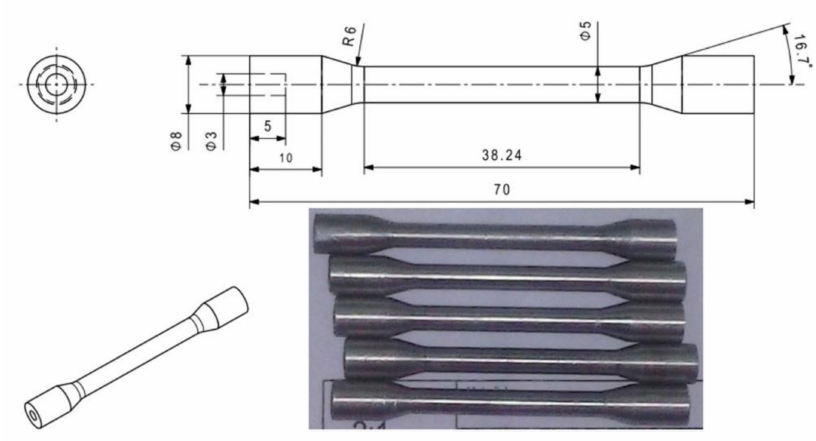
Figure 1. Samples for tensile strength testing (dimensions in mm).